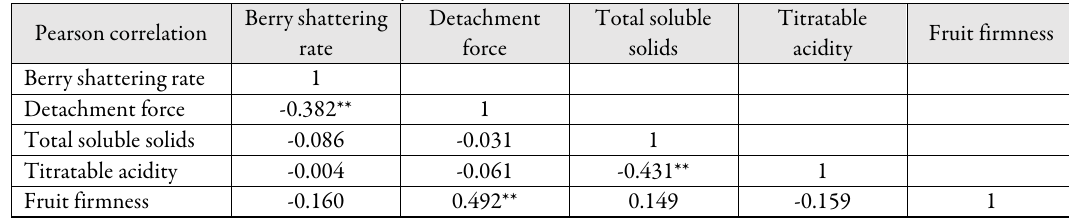
Berry shattering Detachment Total soluble Titratable Fruit firmness rate force solids acidity